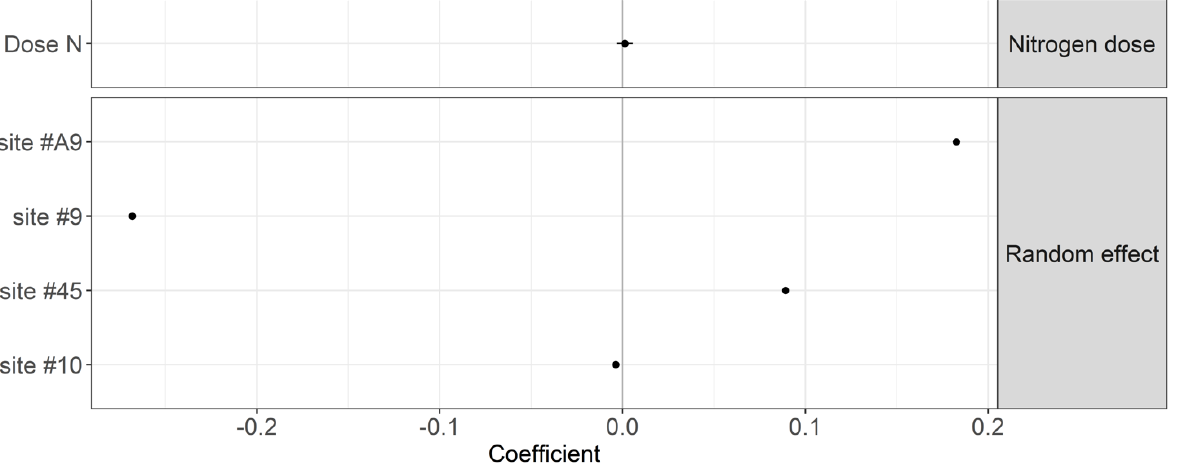
Figure 4. Coefficients of the mixed model linking the TBI stabilization factor (S) to the N dosage and sites with a 95% compatibility interval.